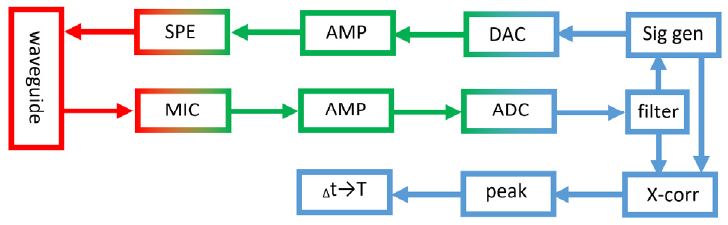
Figure 13. Block diagram of the PAT operations.